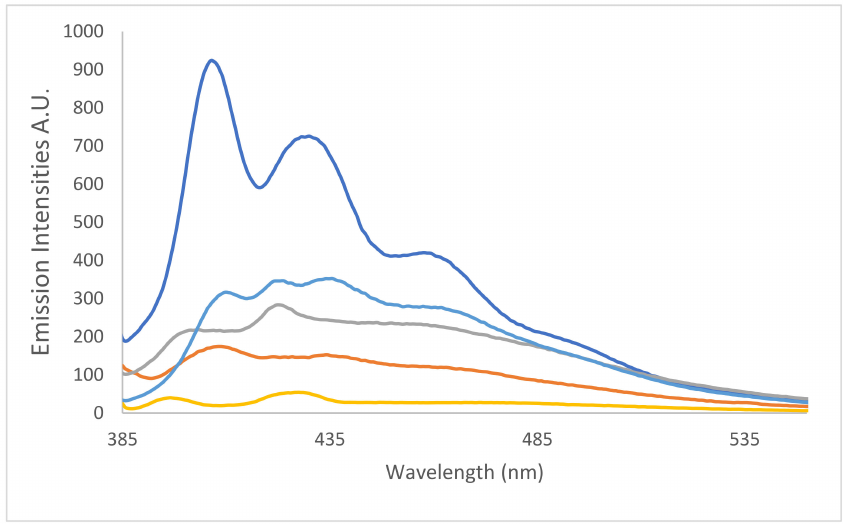
Figure 16. Fluorescence spectra of 6.2 × 10 − 5 M of 2-amino-4-hydroxy-6-(4-hydroxy-2-oxo-2H- chromen-3-yl)nicotinonitrile 4 in toluene, CHCl 3 , ethanol, pentanol and formamide, λ ex = 376